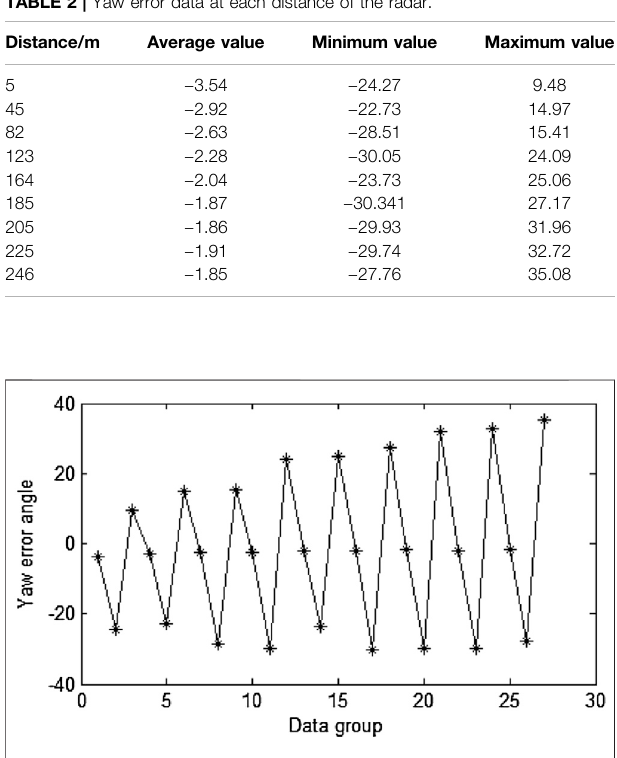
FIGURE 4 | Variation curve of yaw error